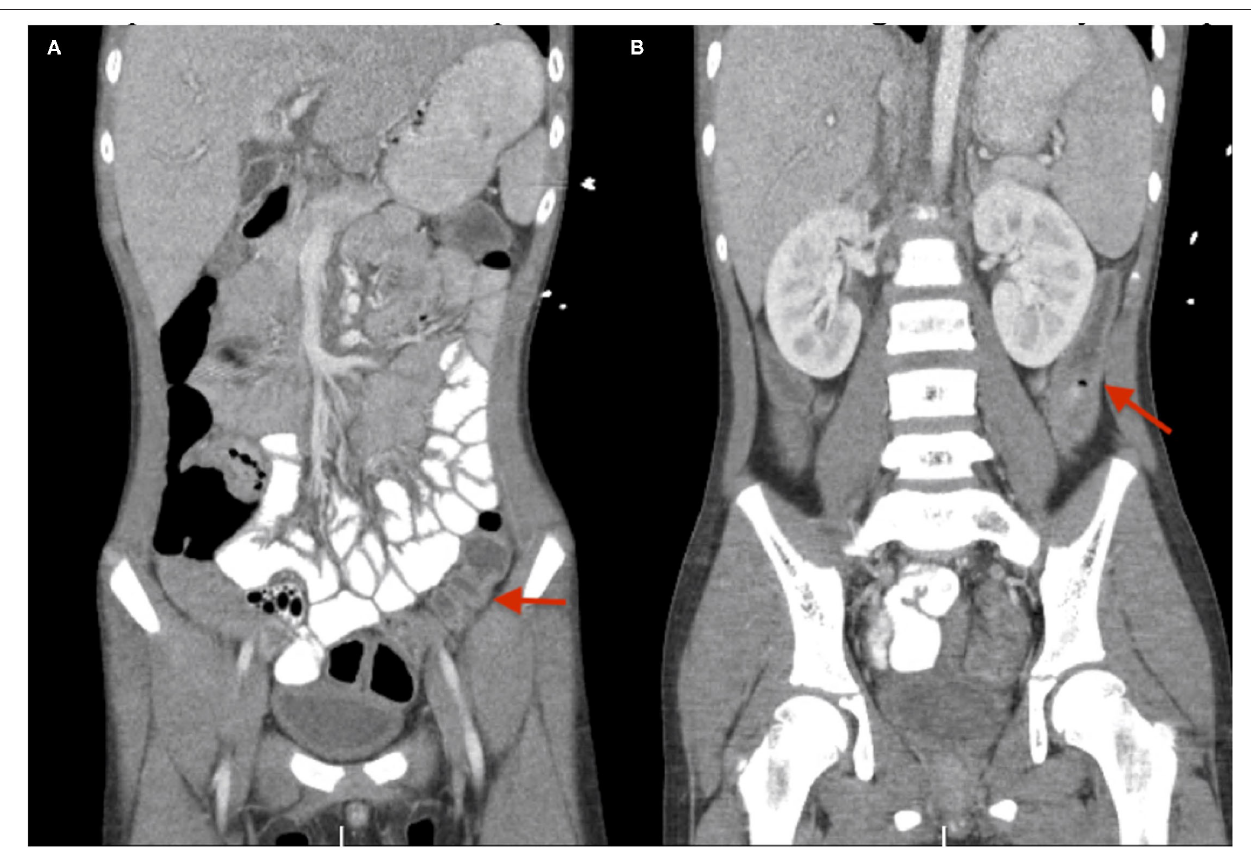
FIGURE 1 | (A,B) CT abdomen pelvis with contrast for case #1. Red arrows depict the descending colon